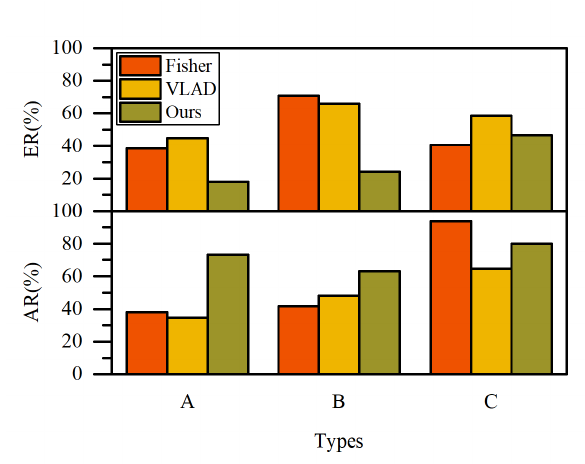
Figure 3 Global descriptors experimental AR and